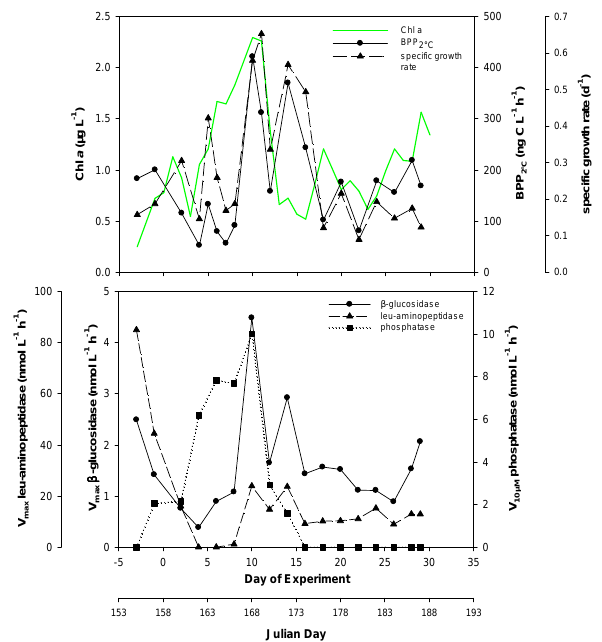
Fig. 2. Temporal development of bacterial production and growth (BPP 2 ◦ C , specific growth rate; upper panel) and extracellular en- zyme activities (leu-aminopeptidase, β -glucosidase, phosphatase; lower panel) in the Kongsfjorden.